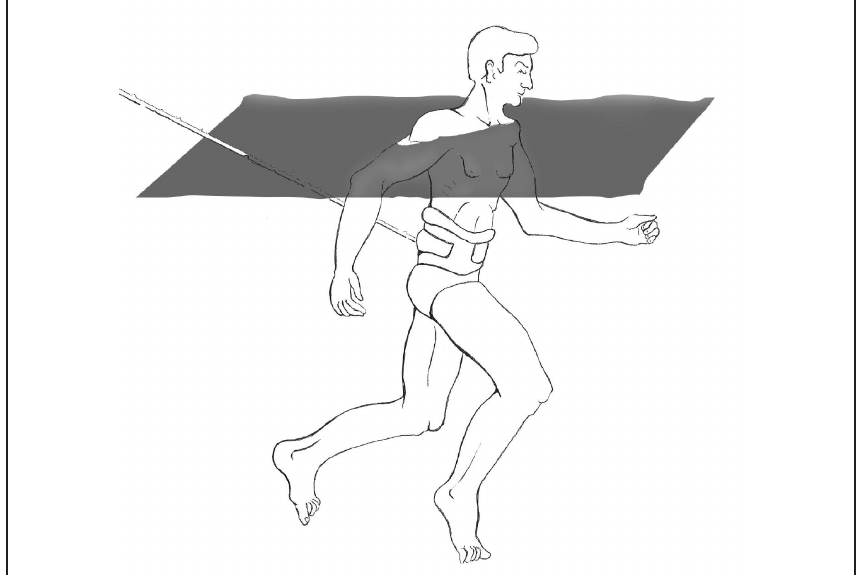
Figure 2. Symbolized drawing of deep water running.